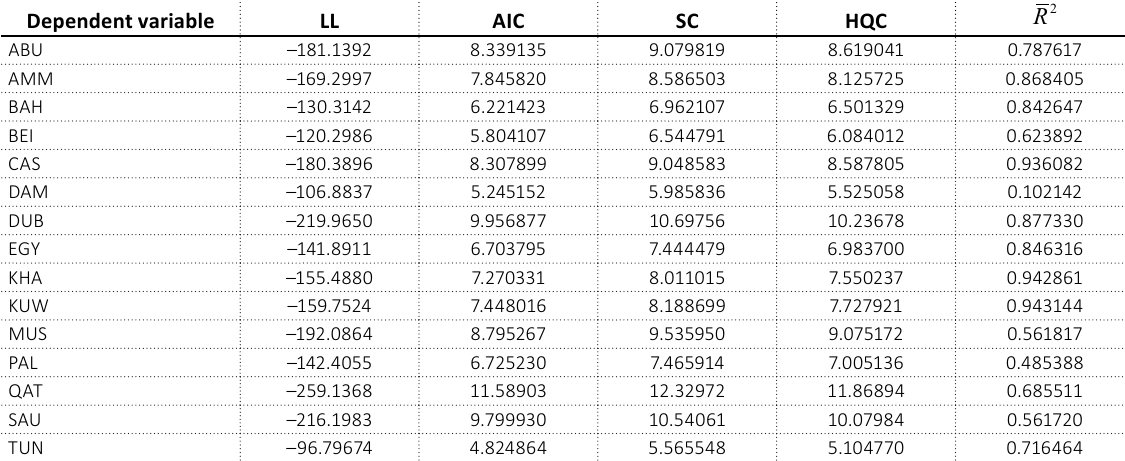
Table 8. Summary results of model estimation, Model 3: